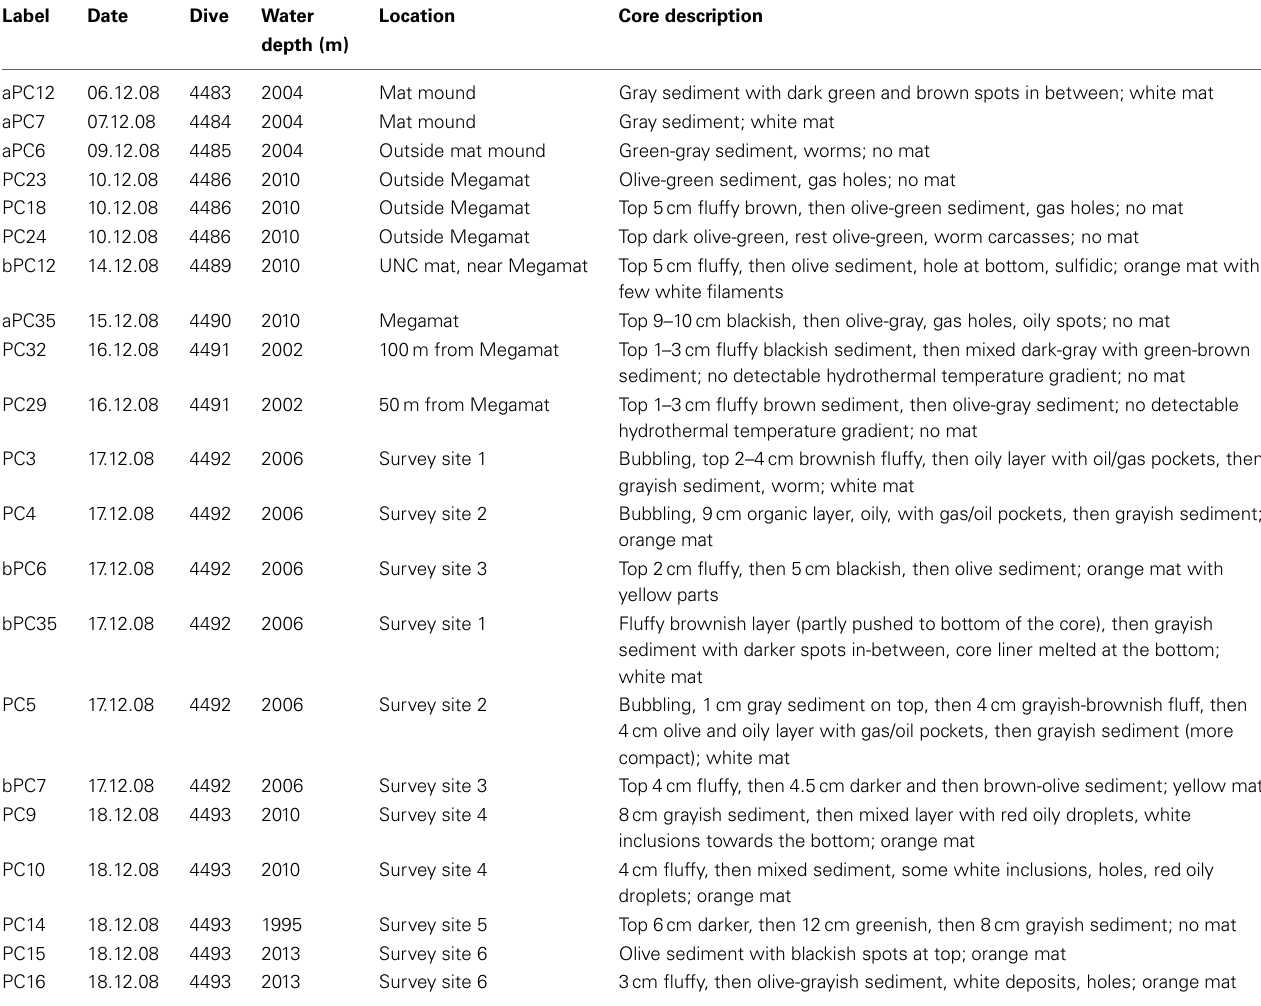
Table 1 | Cores analyzed in this study by